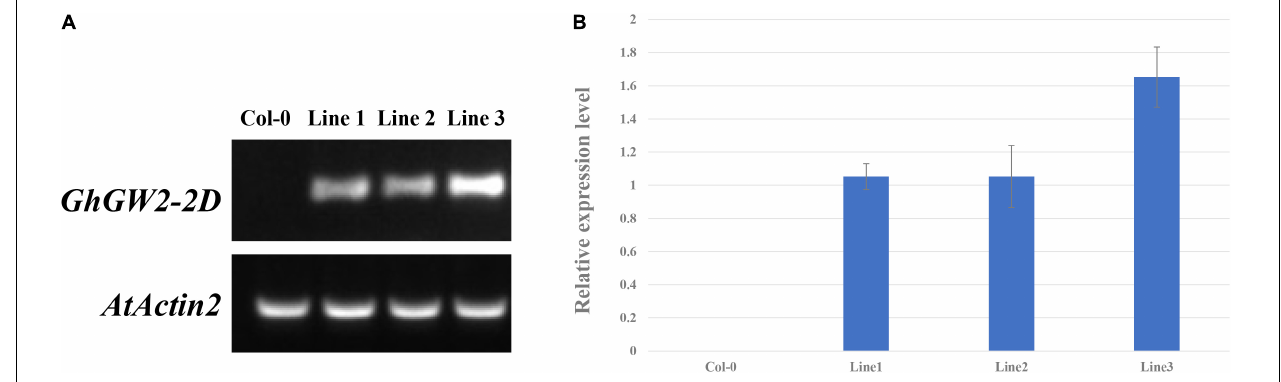
FIGURE 6 | The overexpression of GhGW2-2D decreases the seed size in Arabidopsis . (A–D) Seed phenotype of Col-0 (A) and transgenic lines 1 (B) , 2 (C) , and 3 (D) ( n = 30). Bar = 500 µ m. (E–H) Seedling phenotype of Col-0 (E) and transgenic lines 1 (F) , 2 (G) , and 3 (H) ( n = 20). Bar = 1 mm. The relative seed (I) and cotyledon (J) area of seeds from transgenic lines compared to Col-0. Values in (I) and (J) are given as mean ± SE relative to the respective Col-0 values, set at 1. ∗∗ represents significant differences at the P < 0.01 level.